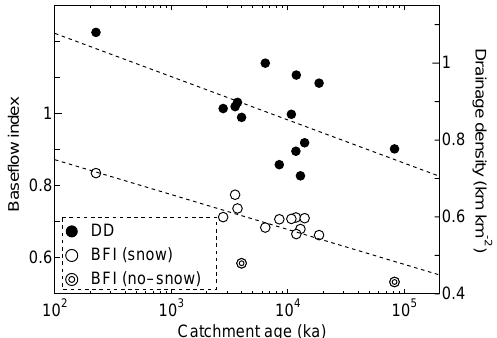
Figure 5. Influence of catchment age on baseflow index ( R = − 0 . 756, p = 0 . 0017) and drainage density ( R = − 0 . 603, p = 0 . 0222).